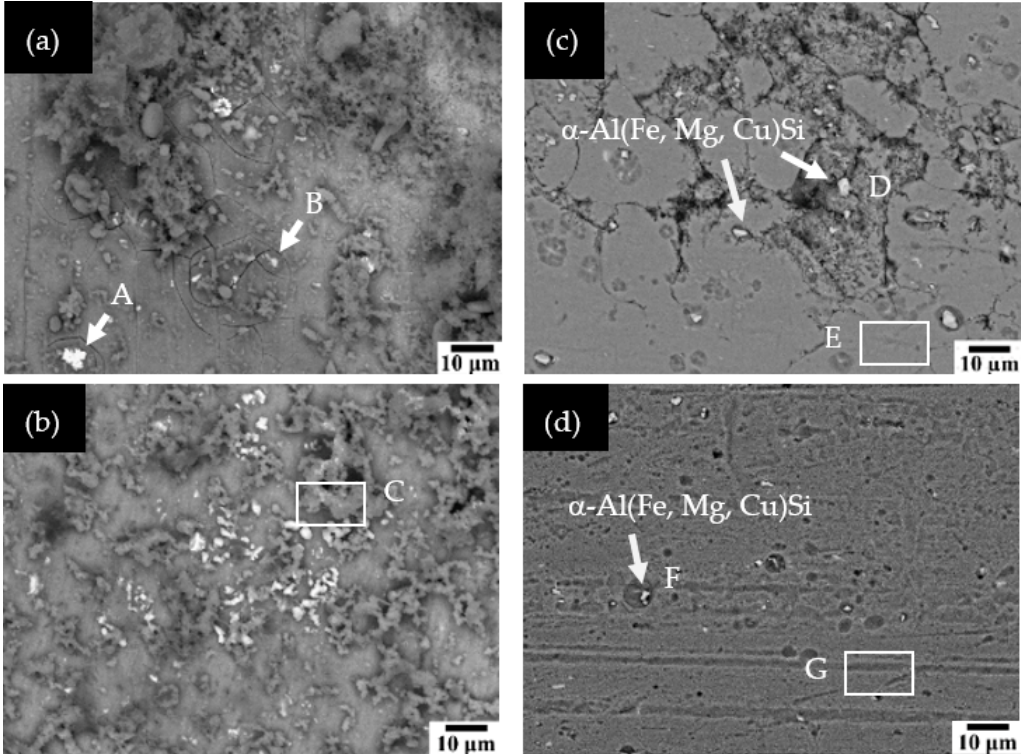
Figure 3. SEM images of AA6061-T6 surface after 30 days of exposure in Caribbean seawater for ( a ) laminar and ( b ) stationary flow conditions and after removal of corrosion products for ( c ) laminar and ( d ) stationary flow conditions. Table 3. EDS analysis (wt.%) of aluminum alloy 6061-T6 surfaces: after 30 days of exposure in seawater under laminar flow (zones A, B, C) and after removal the layer of corrosion products (zones D, E, F, G). Element